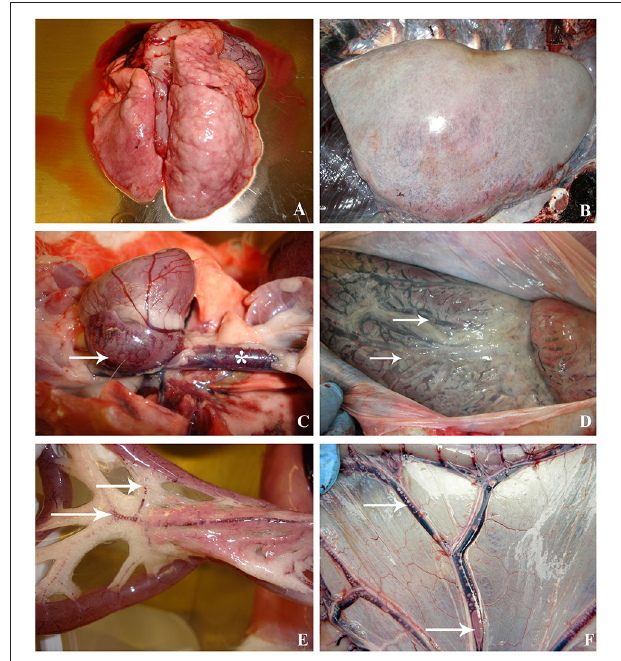
FIGURE 2 | Macroscopic lesions compared between decompression sickness in rabbits (left row) and cetaceans (right row). (A) Presence of pale lungs with distended and enlarged areas, mainly denoted in the right side, in a rabbit dead by C/D protocol. (B) Emphysematous lungs in a beaked whale diagnosed with decompression-like sickness. (C) Heart of a C/D mortality rabbit with congestion and macroscopic bubbles in the right atrium (white arrow) and caudal vena cava (white star). (D) Heart of a beaked whale with dilated right atrium due to the presence of macroscopic bubbles, which are also observed in the coronary vessels (white arrows). (E) Mesenteric area of a C/D mortality rabbit. Emphysematous fat and congestion of blood vessels running through mesenteric fat. The presence of gas bubbles in the mesenteric veins is denoted (white arrow). (F) Mesenteric area of a Risso’s dolphin with visible bubbles circulating in the mesenteric vessels (white arrows) and